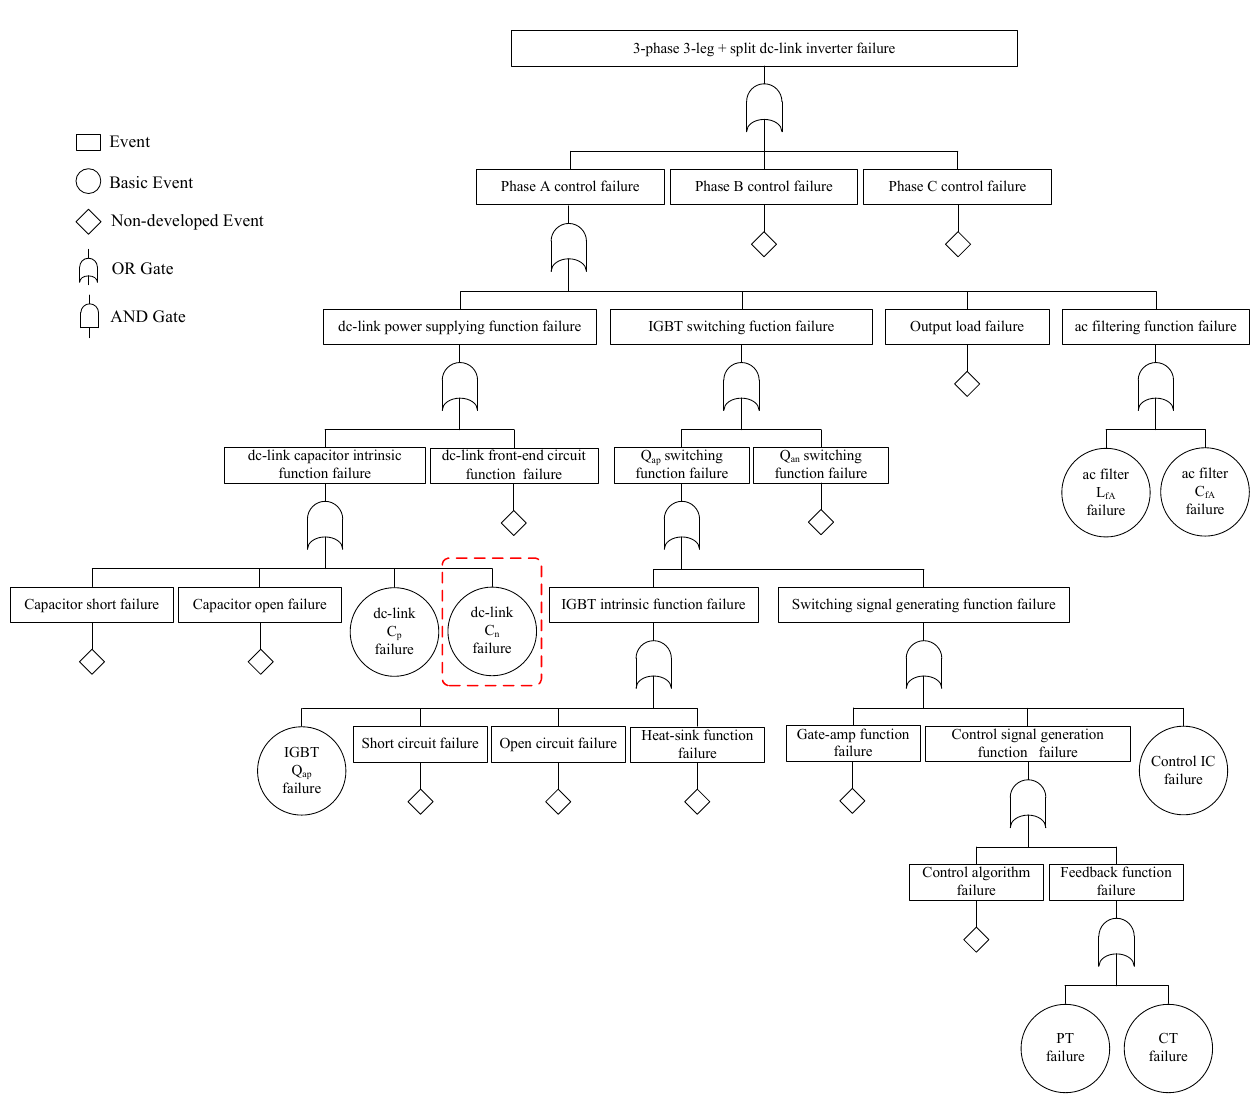
Figure 10. Fault-tree of three-phase 3-leg inverter with split DC-link capacitors.